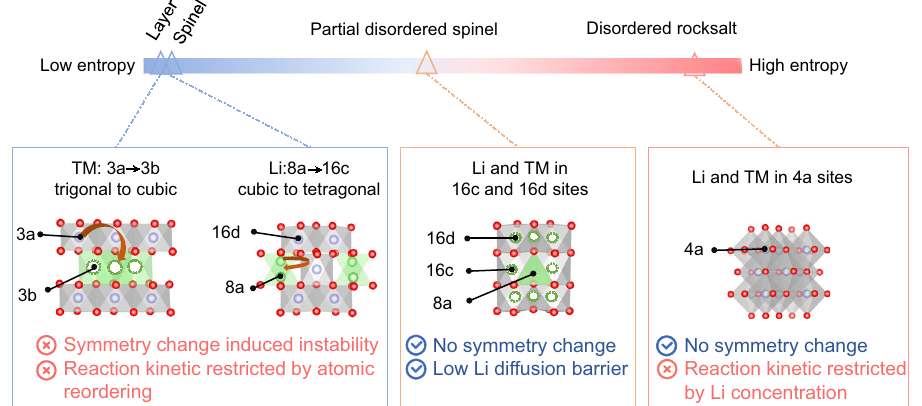
Fig. 1 | Schematic illustrations of the cation reordering and symmetry change upon lithiation/delithiation within different Li x TM y O 2 phases. The 3a, 16c, 16d, and 4a octahedral sites are represented by gray octahedrons, while the 3b octa- hedral sites and 8a tetrahedral sites are shown as green octahedrons and